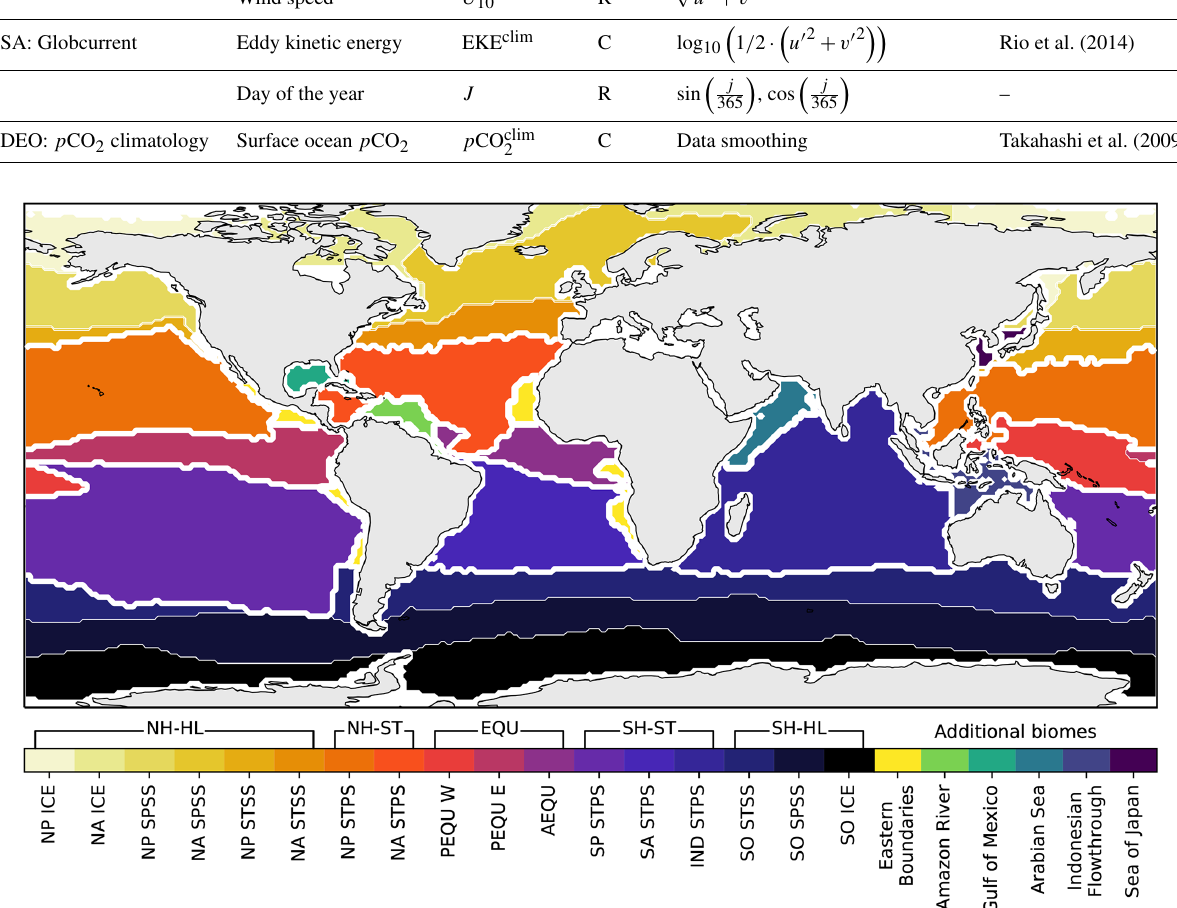
Figure 3. Regions or biomes as defined by Fay and McKinley (2014). Unclassified regions from the original data have been assigned manually in this study and are shown by the separate colours. This modified configuration of the CO 2 biomes is referred to as BIO23 in this study. The sea mask used in Landschützer et al. (2014) has been applied. For the biome abbreviations (below the colour bar), see Fay and McKinley (2014). The abbreviations above the colour bar are used in this study, where selected biomes are grouped together. Thick white lines show the boundaries of the grouped regions. Prefixes are as follows: NH is Northern Hemisphere and SH is Southern Hemisphere. Suffixes are as follows: HL is high latitudes, ST is subtropics, and EQU is